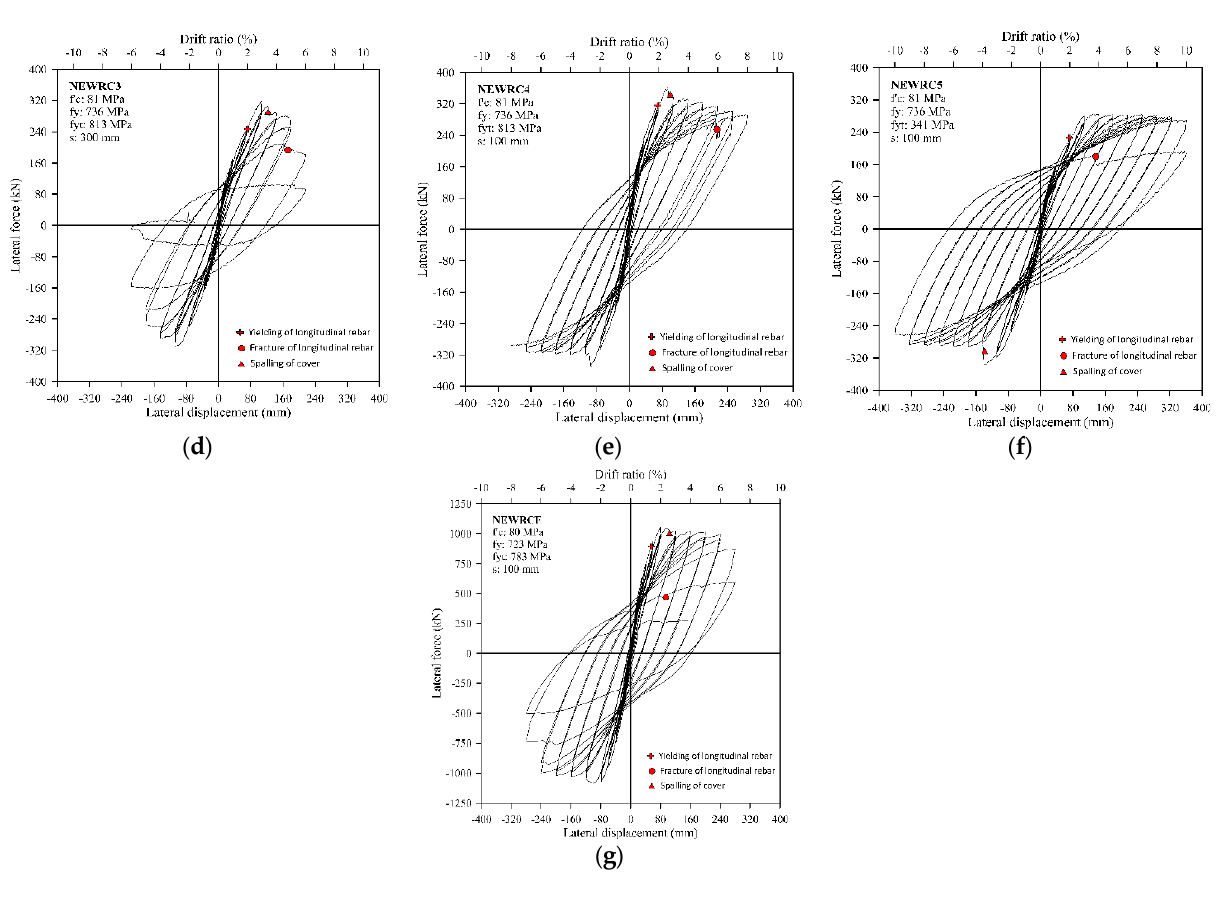
Figure 8. Hysteresis loops of specimens: ( a ) BMRC1; ( b ) NEWRC1; ( c ) NEWRC2; ( d ) NEWRC3; ( e ) NEWRC4; ( f ) NEWRC5; ( g ) NEWRCF.